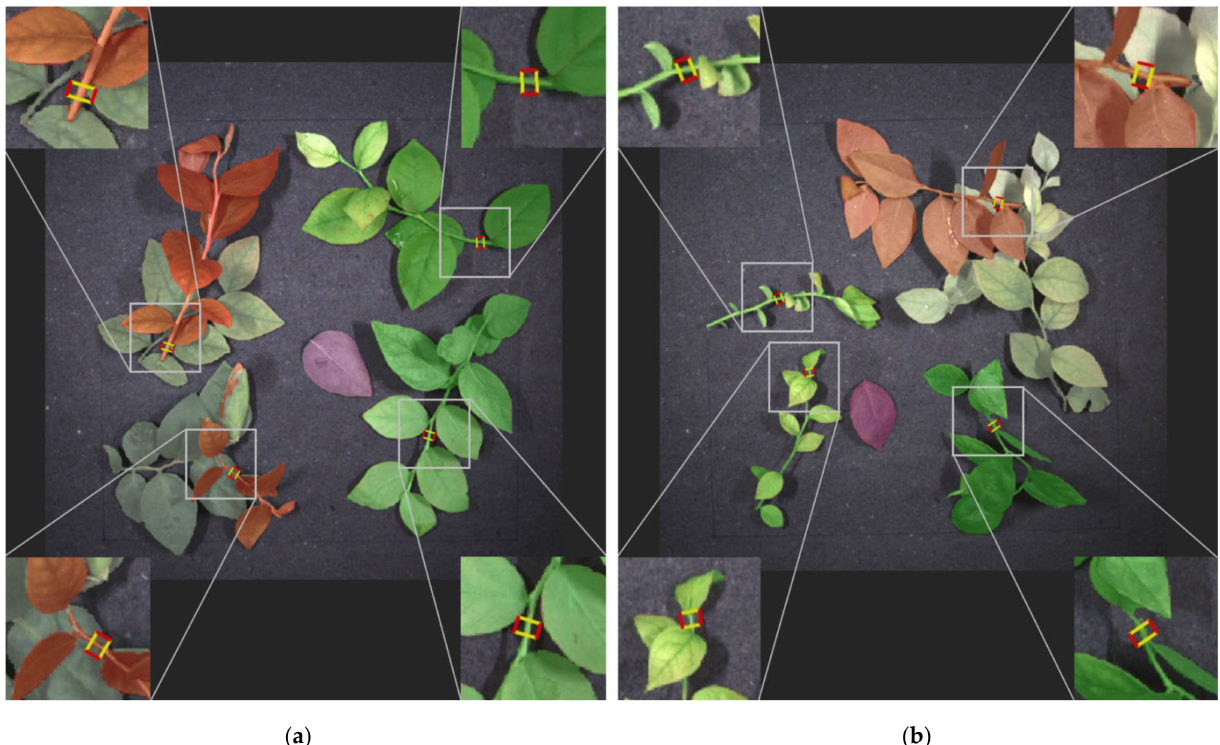
Figure 10. Examples of grasp detection on the test dataset. ( a ) Normal occlusion image. ( b ) Complex occlusion